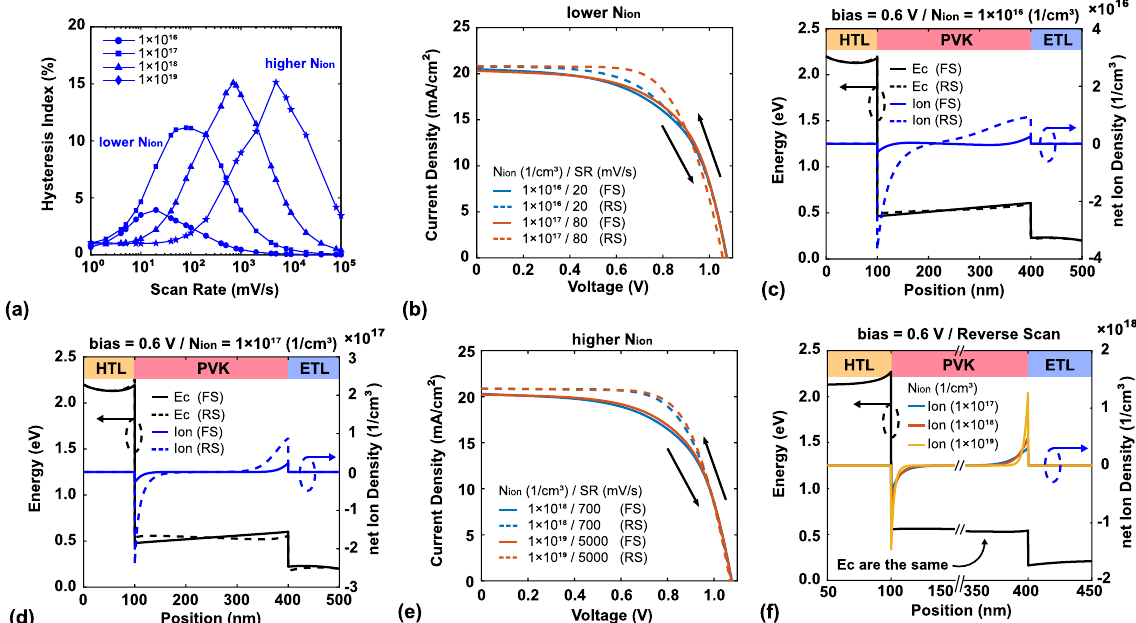
− 3 . ( b ) J – V characteristics − 3 , respectively. ( e ) J – V characteristics for − 3